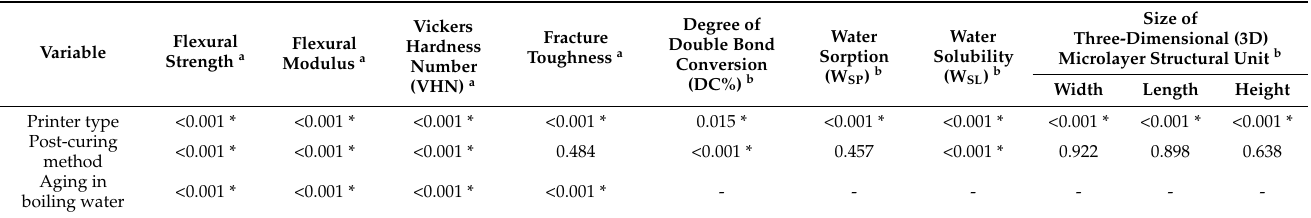
Table 1. p -values acquired by 3- and 2-way ANOVA for the evaluated mechanical properties.